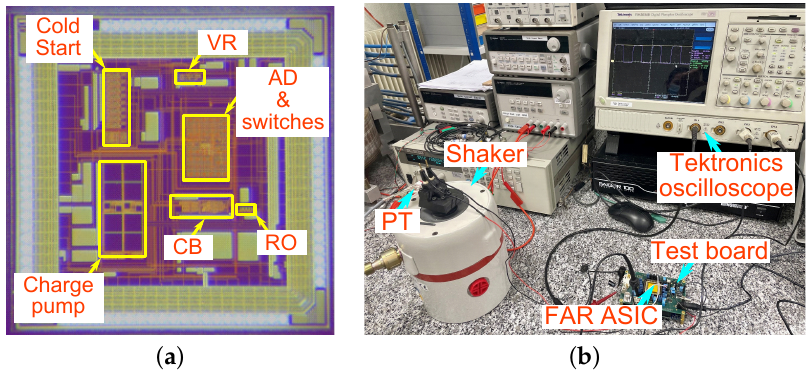
Figure 12. ( a ) FAR ASIC micrograph. ( b ) Experimental test bench. Note that with C L = 100 µF, the voltage ripple ∆ V on V rec is negligible (i.e., be- low 1 mV).